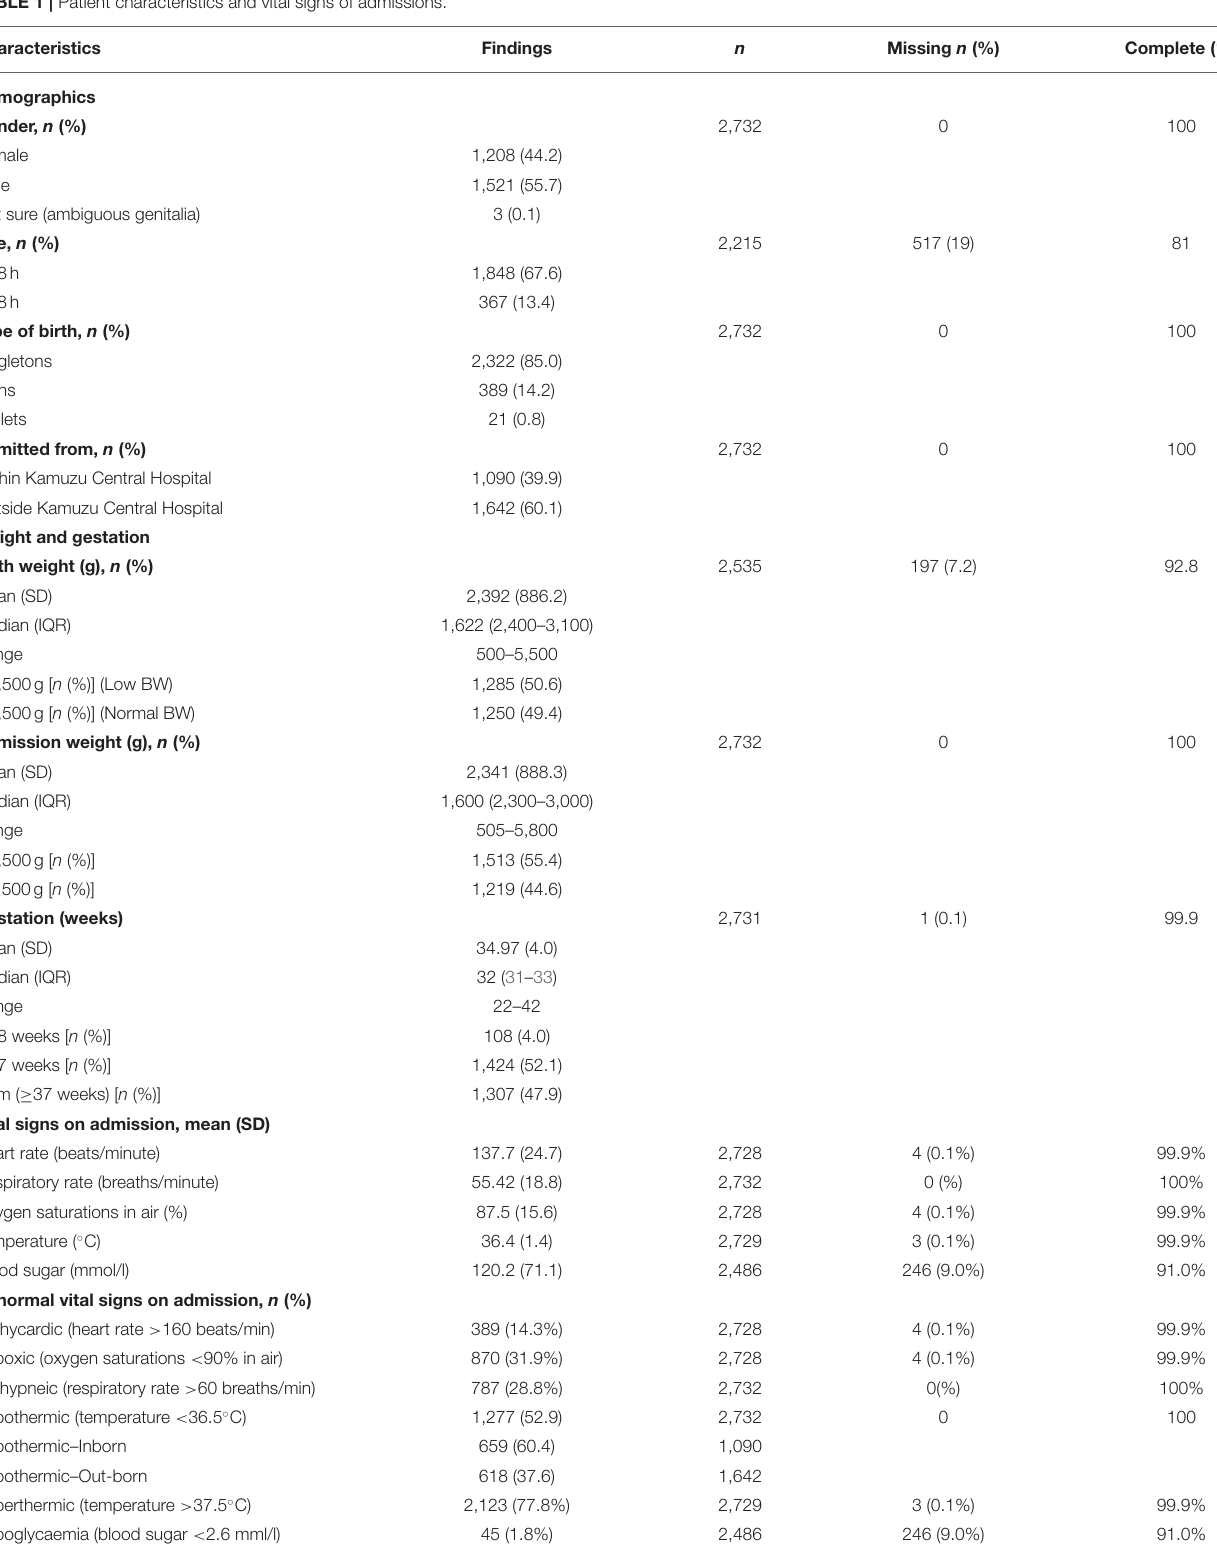
TABLE 1 | Patient characteristics and vital signs of admissions.